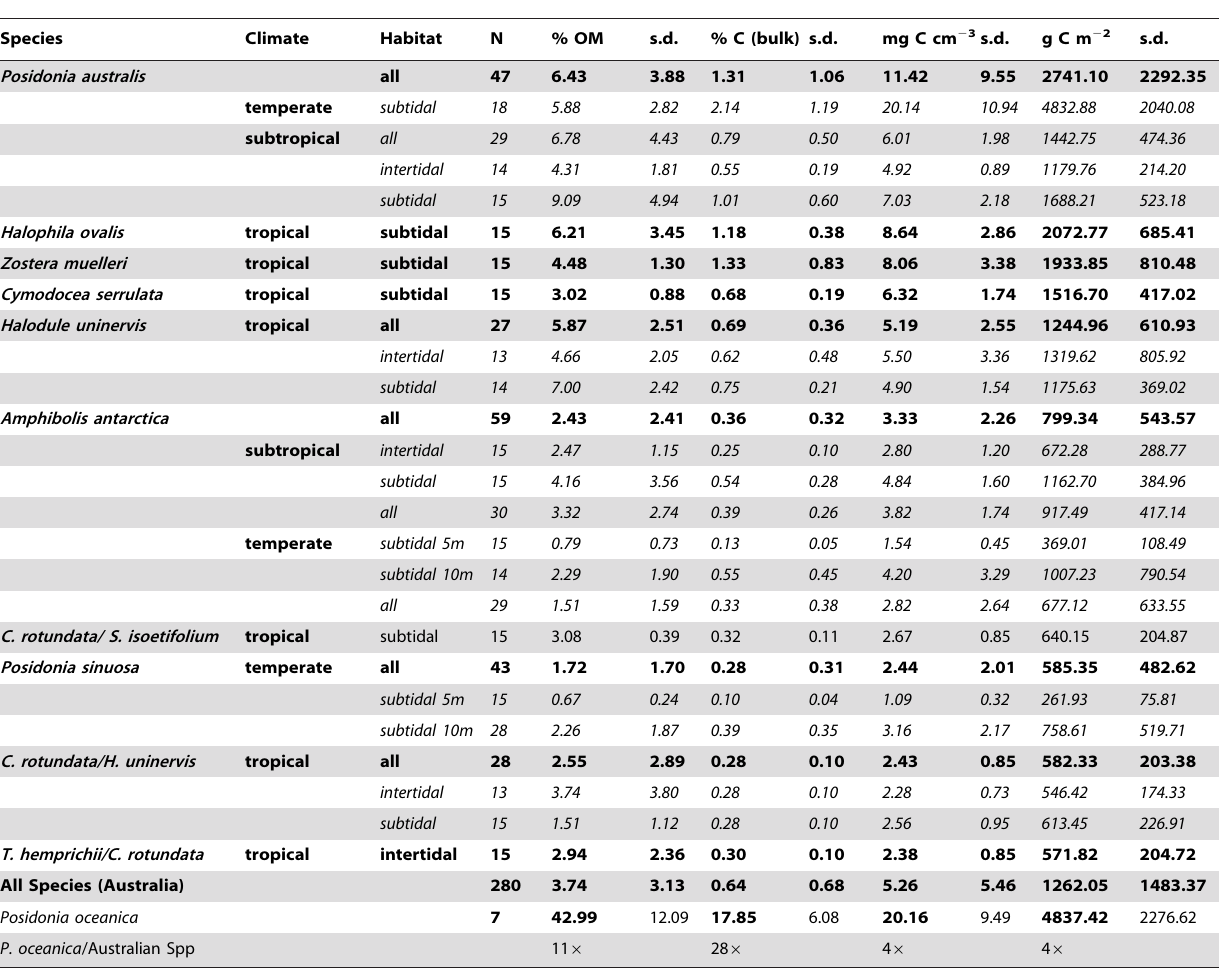
Table 4. Sediment characteristics of Australian seagrass habitats and Posidonia oceanica